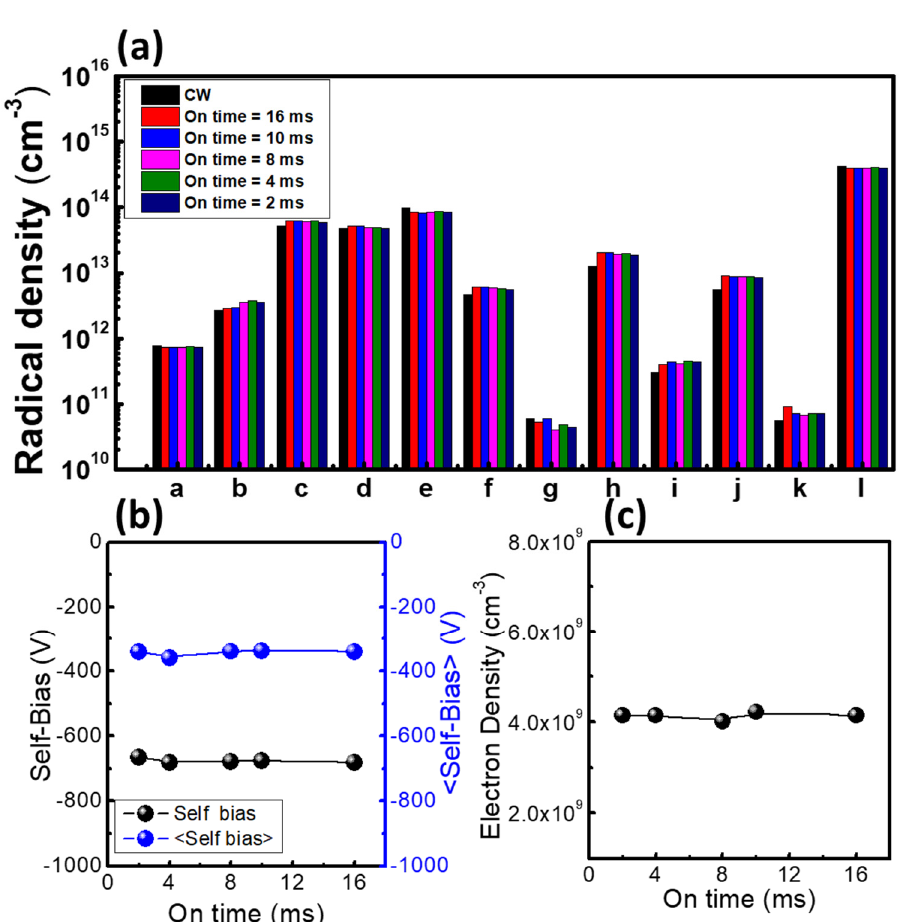
Figure 6. Diagnostic data as a function of on/off time: ( a ) radical densities, ( b ) self-bias and averaged self-bias, and ( c ) electron density. The parameters for these experiments were a RF power of 400 W, a pressure of 20 mTorr, a C 4 F 8 /Ar gas ratio of 1:1, and a pulse off-time equal to the on-time.